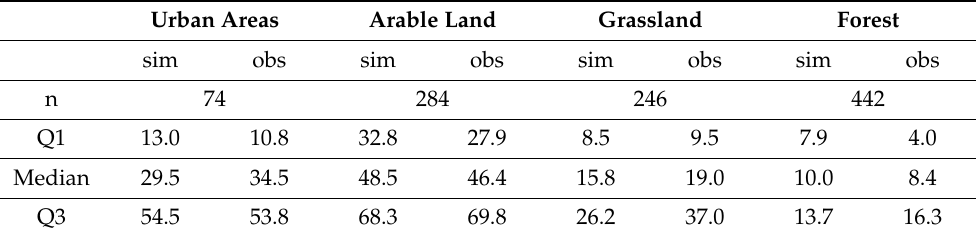
Figure 8. Comparison of overall agreement (top) and agreement for single deviation classes (down) (difference of classified average simulated nitrate concentration in leachate and classified median of measured nitrate concentration in groundwater) differentiated according to the main types of use: urban ( A ), arable land ( B ), grassland ( C ), and forest ( D ). Table 4. Number of measuring points (n), first quartile (Q1), median, and third quartile (Q3) for simulated and observed nitrate concentrations for the land use